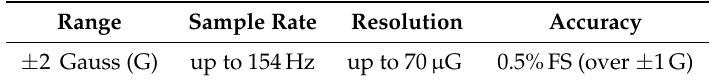
Table 5. The properties of the HMR2300 magnetometer. FS, Full Scale